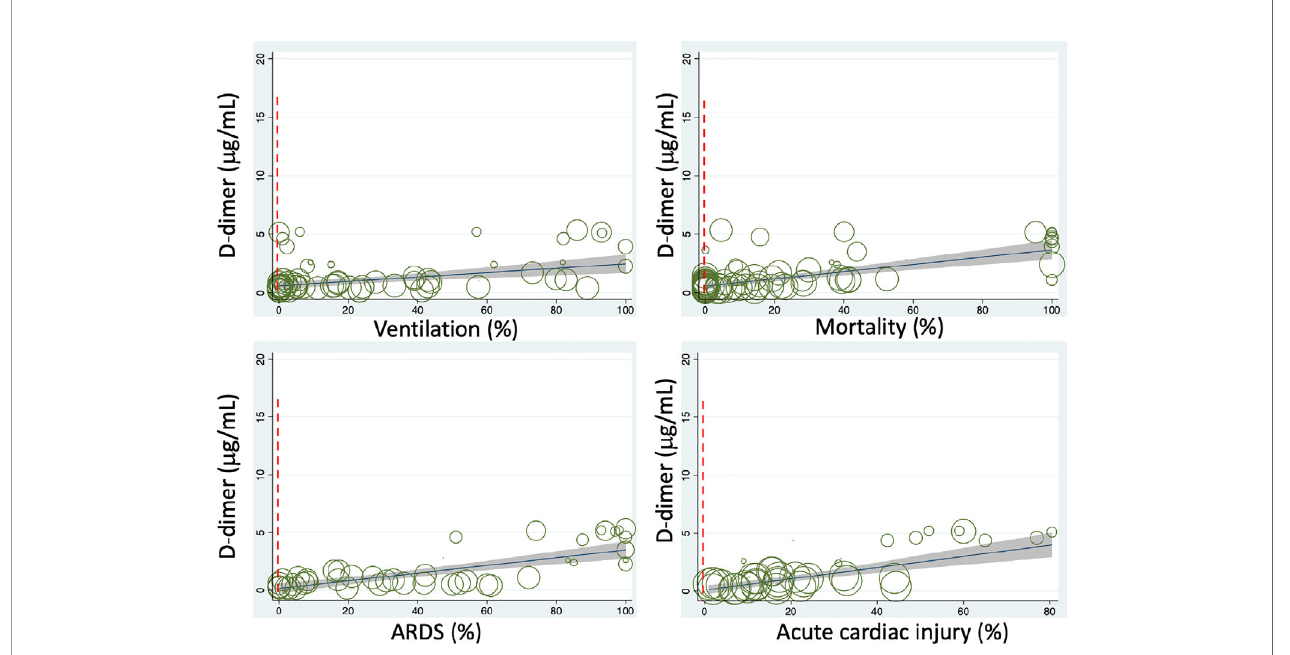
FIGURE 3 | Meta-regressions of plasma D-dimer level on admission with some clinical variables. Dashed vertical red lines indicate the normal